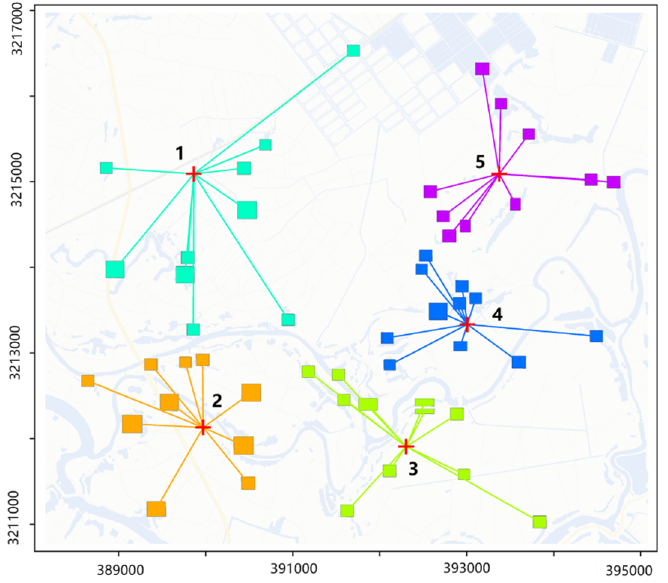
Figure 8. Flight trajectories of the UAVs based on the manual scheduling method.